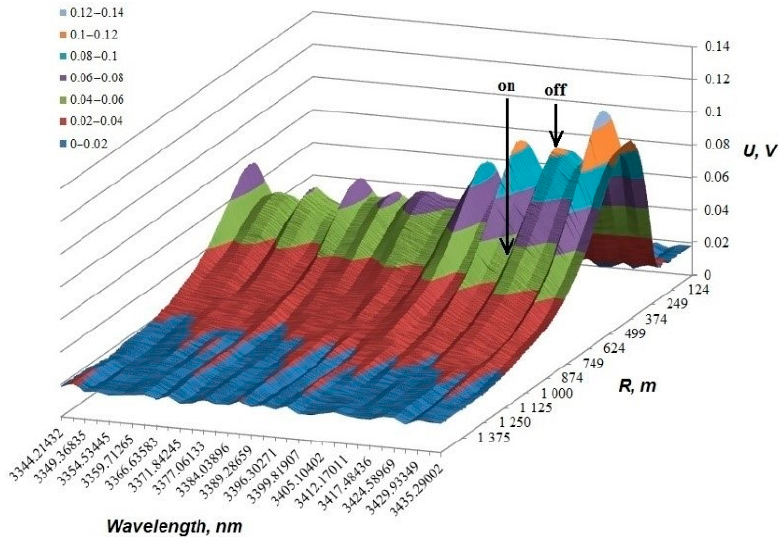
Figure 9. Lidar signal recorded under wavelength tuning in the region of OPO laser radiation absorption by CH 4 .